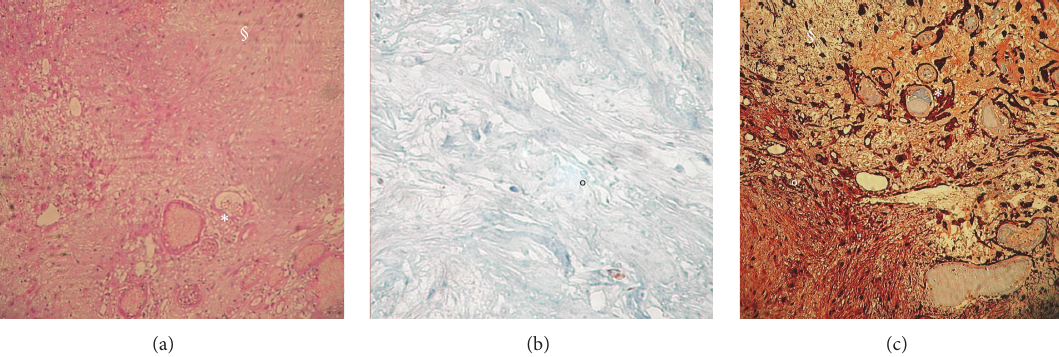
Figure 2: (a) H&E 40x, (b) Ki67, and (c) S-100 immunostaining of the lesion. Note the presence of microcystic areas ( ∗ ) in a loose fibrillary stroma (§) finely admixed with hypercellular areas composed of bundles of spindle-cells ( ∘ ).